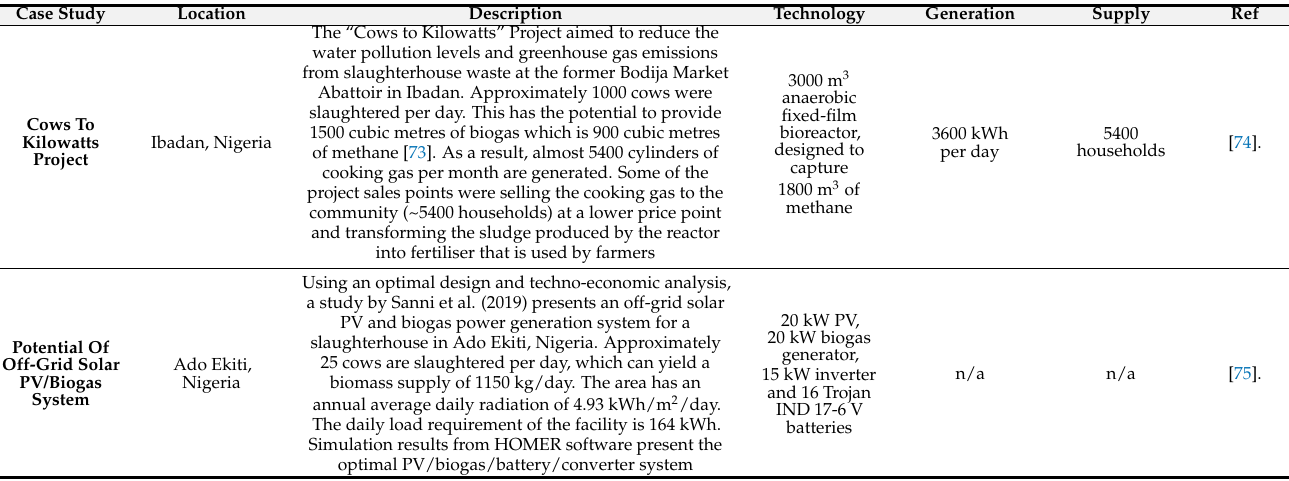
Table 11. Case Studies in